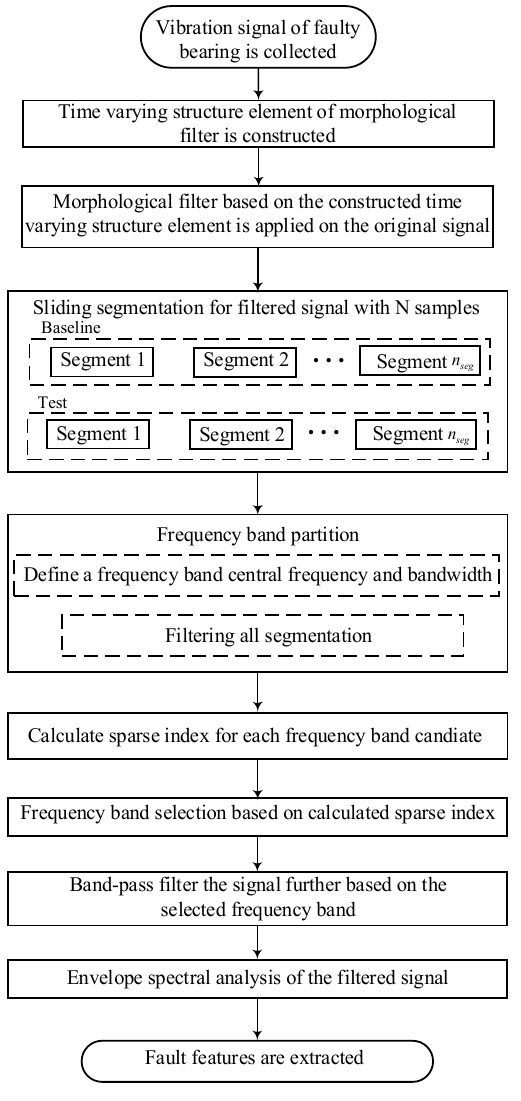
Figure 5. Flow chart of the proposed method.